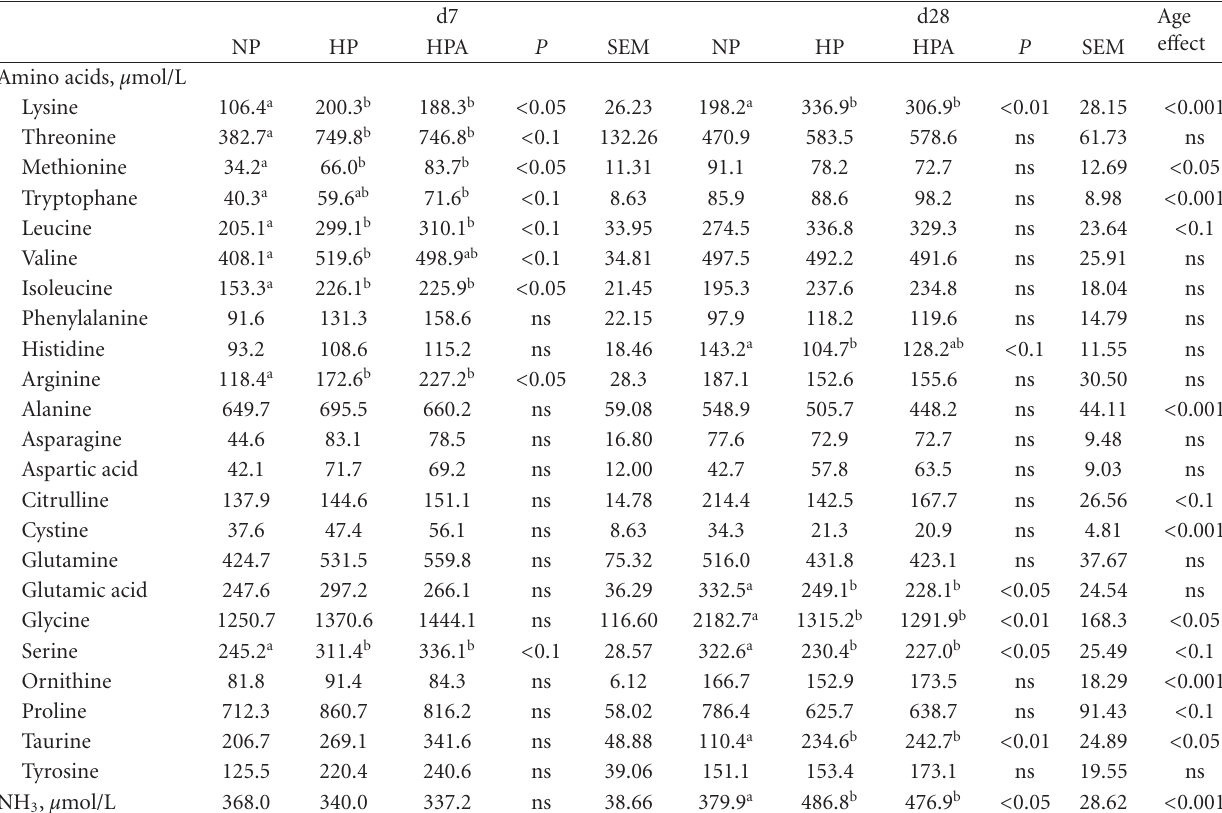
Table 7: Plasma amino acid and urea concentrations measured in piglets fed NP, HP, and HPA diets at d7 and